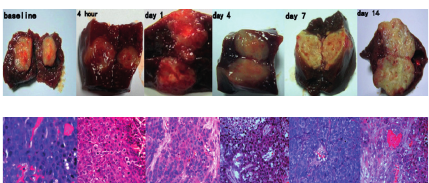
Figure 6: Gross pathology of the rabbit VX2 liver tumor model and hematoxylin and eosin staining ( × 400) of the tumor in the M410 group at baseline, 4 h, 1, 4, 7, and 14 days after treatment. The intrahepatic mass is clear without capsule formation, and the tumor is grayish white and similar to a fish flesh. There are multipoints hemorrhagic foci in the tumor. The tumor was tough and clearly demarcated with the surrounding liver tissue. Corresponding under the light microscope observation, from the baseline to day 14, revealed that the tumor cells were larger in size, irregular in morphology, disordered in arrangement, and the nuclear atypia was obvious. Scattered patchy or focal necrosis and partial fusion were observed in the tumor tissue. The new capillaries in the interstitium were more abundant, and the fibrous connective tissue grew into bundles.